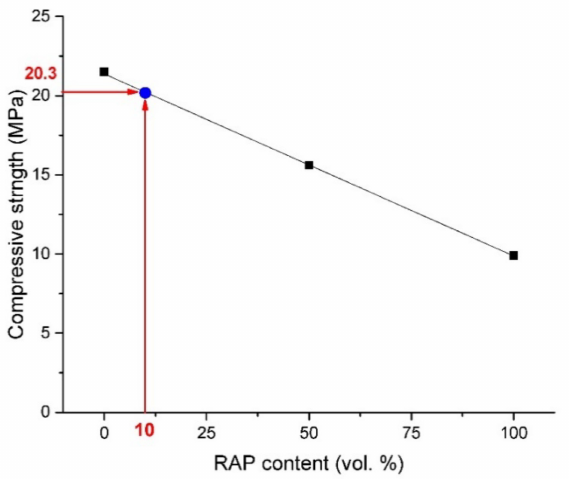
Figure 5. Comparison of compressive strengths obtained on cubic samples of concretes with a di ff erent content of the RAP